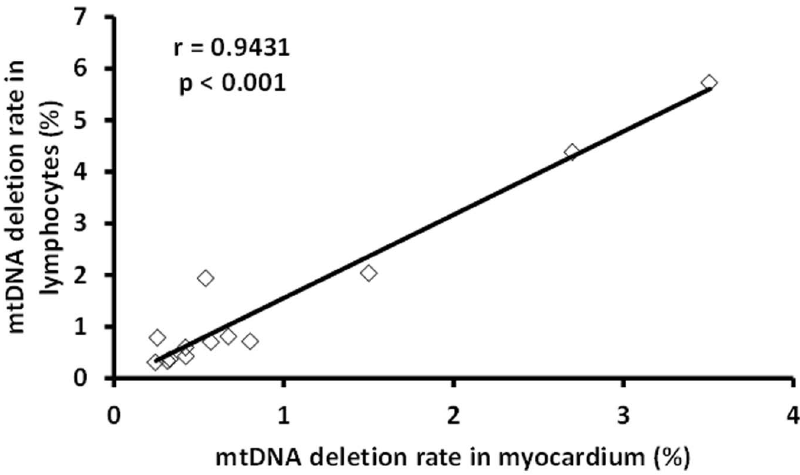
Fig. 1. The correlation curve of summation mtDNA deletion rate between myocardium and lymphocytes in VMD patients.